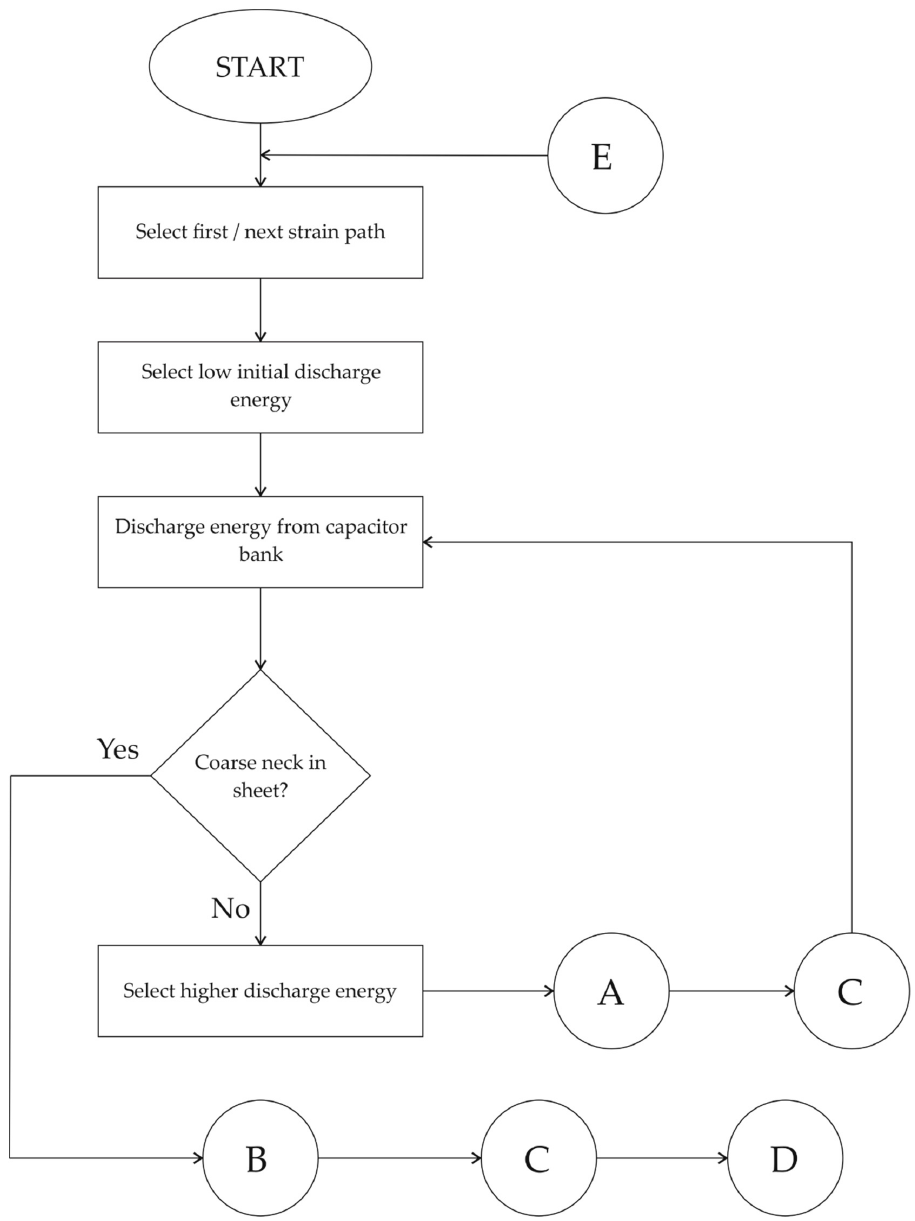
Figure A1. The procedure to determine the EM-FLCs. The flow continues via element D in Figure